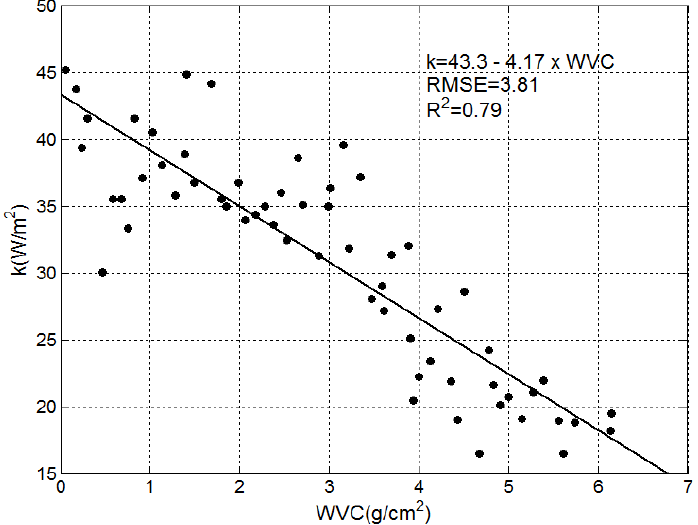
Figure 6. Scattering diagrams of the slope k in Equation (5) as a function of atmospheric WVC under dust aerosol type.